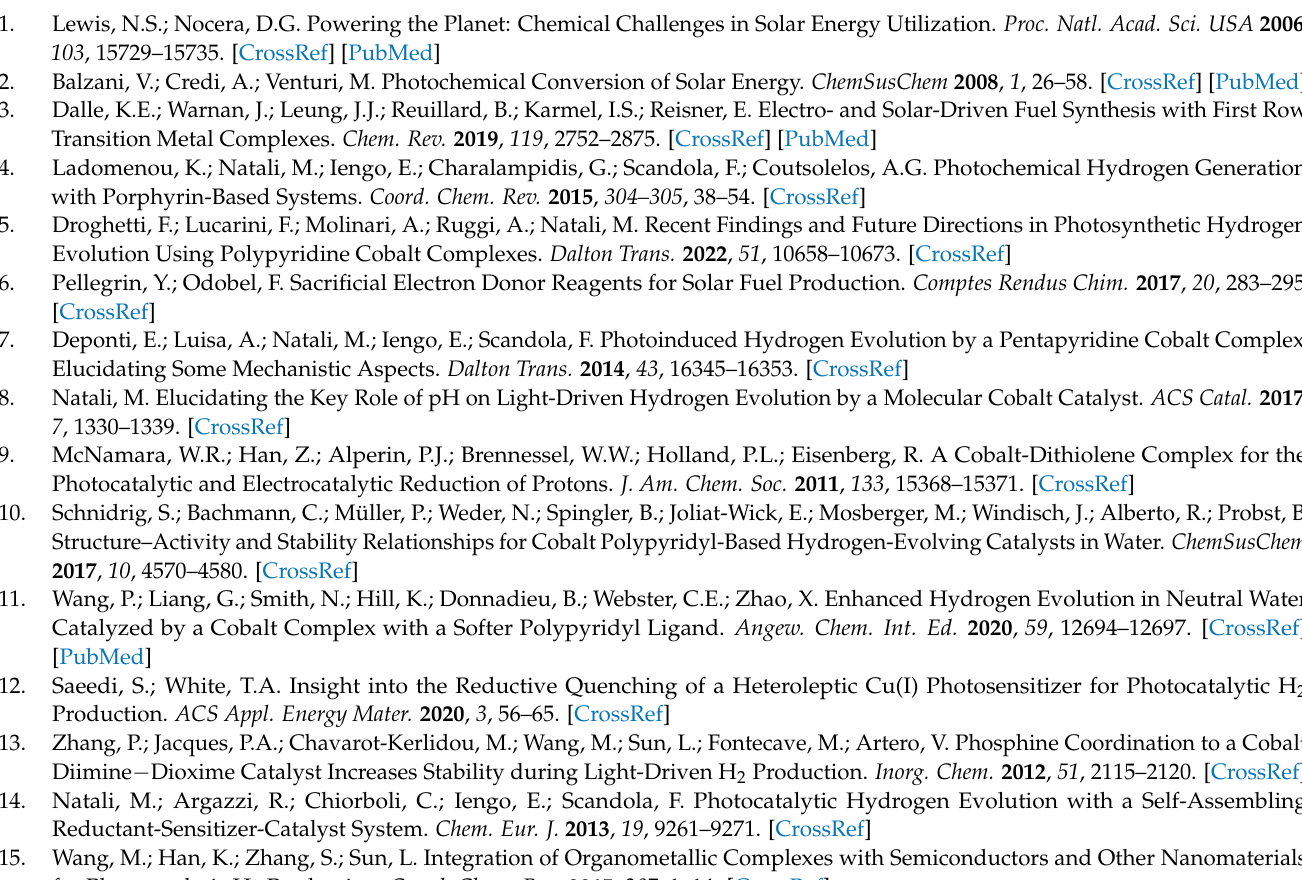
Gaussian functions; Figure S6. Kinetics of hydrogen evolution obtained upon visible light irradiation of aqueous solutions (5 mL) containing 0.11 mM CuInS2@ZnS QDs, 0.5 M ascorbate, 40 µ M C0 at different pH; Figure S7. I0/I ratio vs. catalyst concentration for the quenching of CuInS2@ZnS QDs luminescence by complex C1 ; Figure S8. I0/I ratio vs. catalyst concentration for the quenching